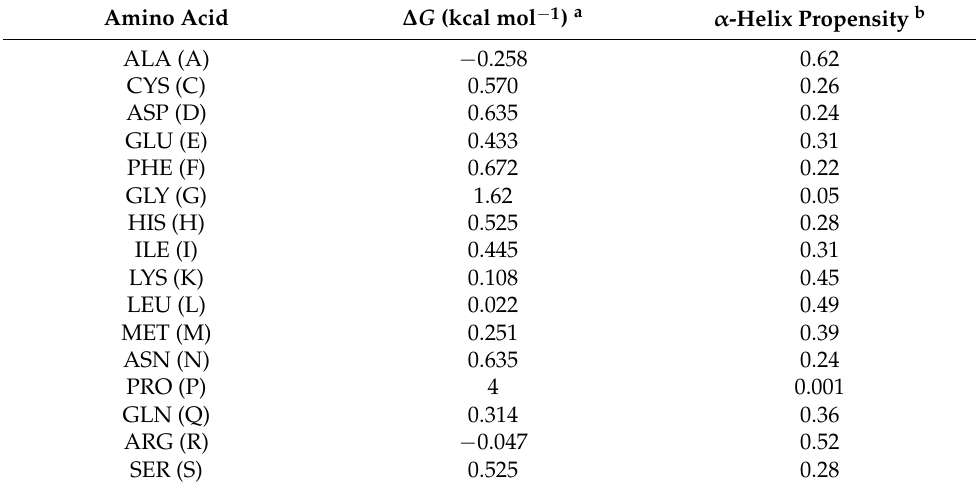
Table 2. Experimental intrinsic propensity for the α -helix measured in short